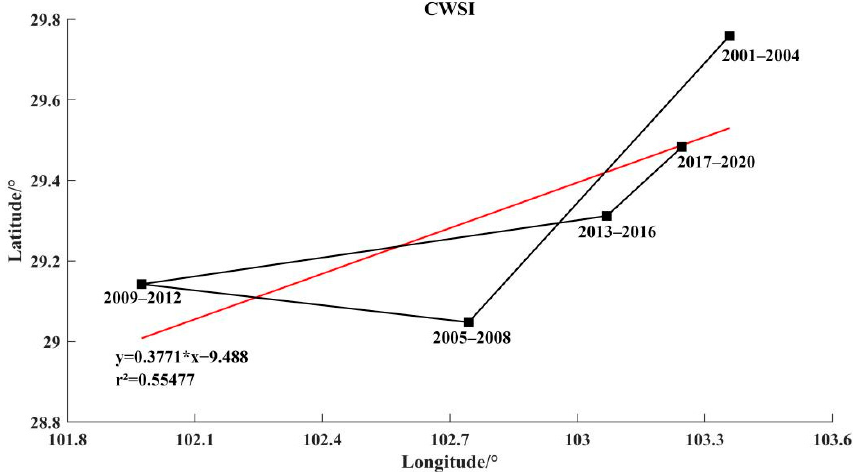
Figure 9. Comparison of barycenter trajectories.